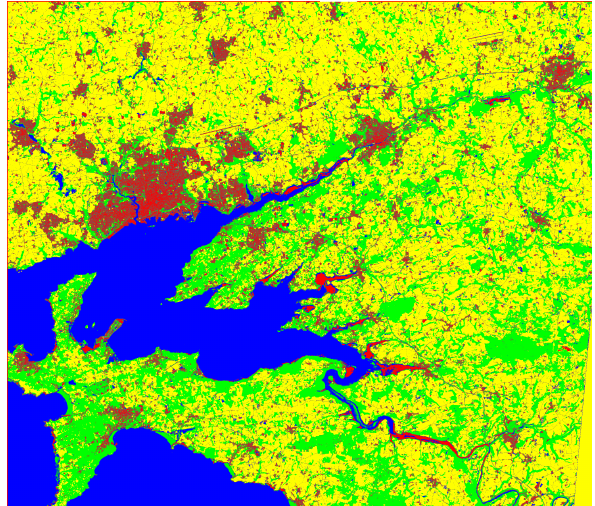
Figure 7. Land-cover produced on ROI-3 with a 4-l net trained on ROI-1 (2014). The size of ROI-3 is 39 × 45 km.